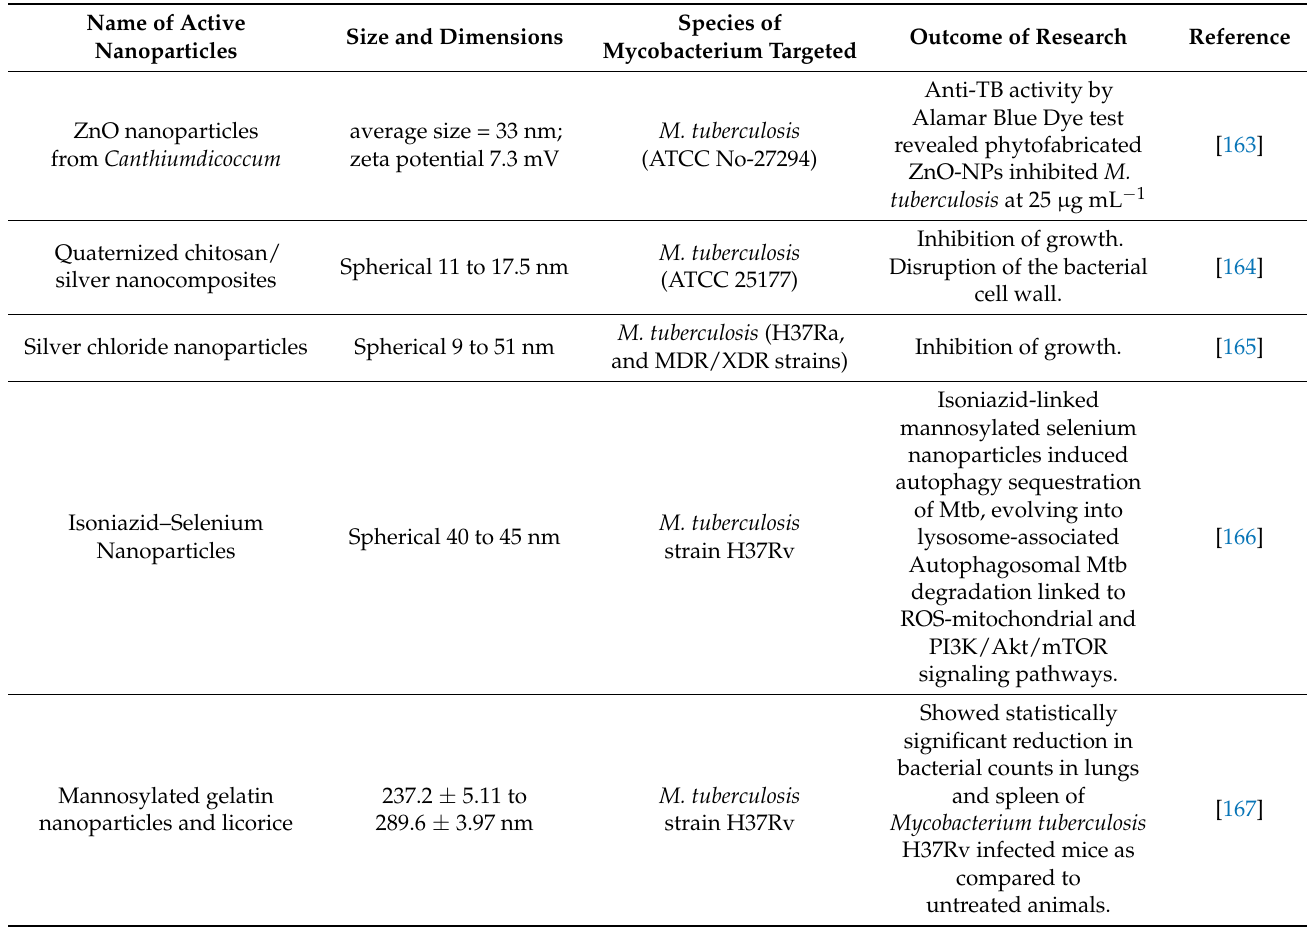
Table 1. Different nanoparticle-based treatments of